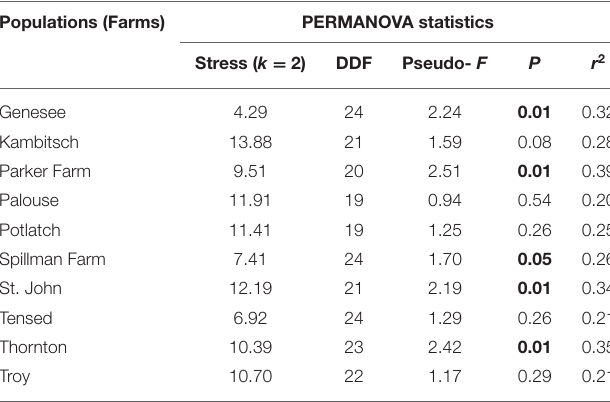
TABLE 3 | Permutational Multivariate Analysis of Variance (PERMANOVA) statistics of half-sibs phenotypic traits among six mother plants across 10 Anthemis cotula populations (see Figure 1 for the ordination plots) a